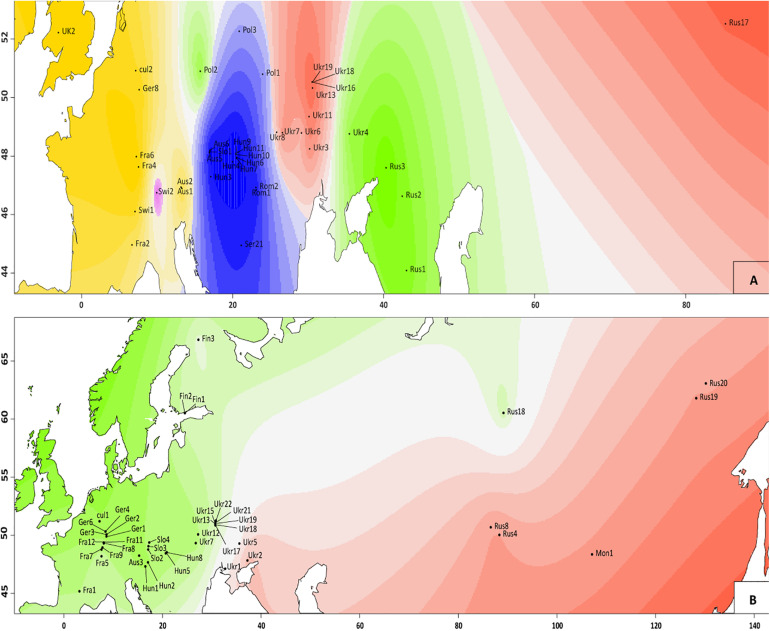
Genetic clusters identified with TESS3R analysis in V. spicata
(A) and V. longifolia
(B) populations. Different colors indicate different clusters inferred (two for V. longifolia and five for V. spicata) and different shading indicates different probabilities to belong to the respective cluster. The graphs are based on the results of STRUCTURE between individuals in the populations, as employed in R package tess3r (details are in main text).